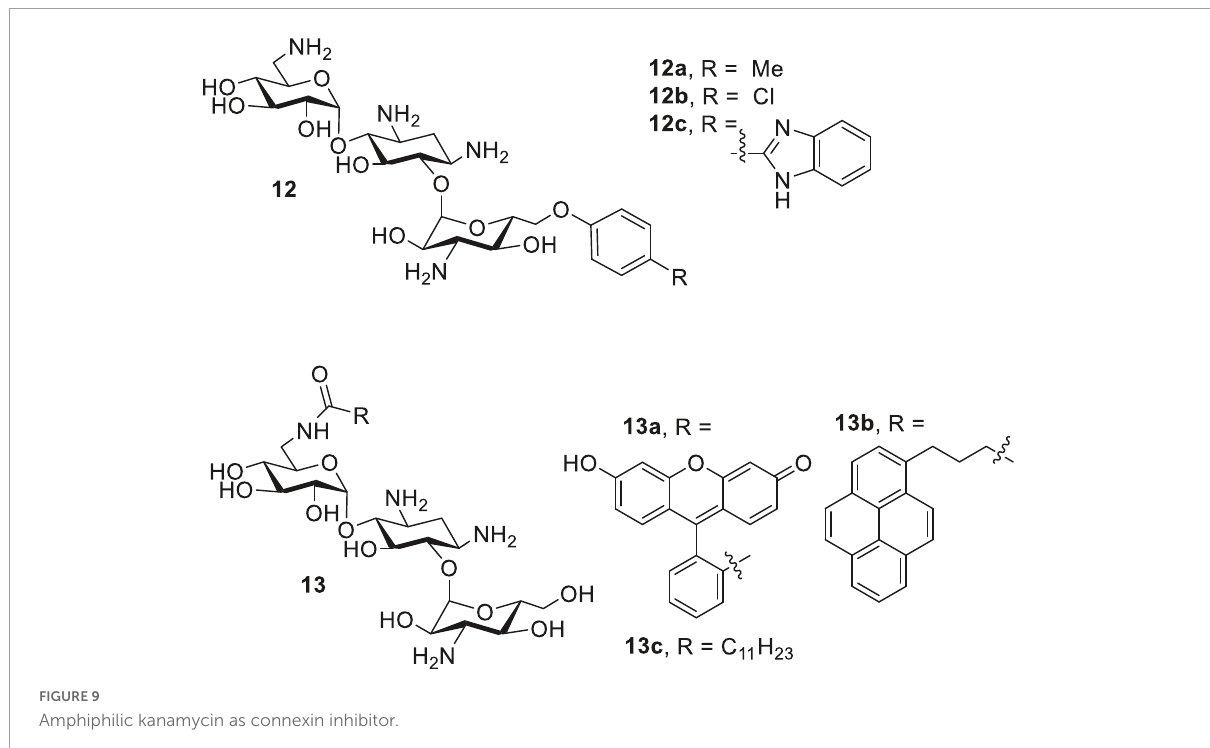
FIGURE9 Amphiphilic kanamycin as connexin inhibitor.